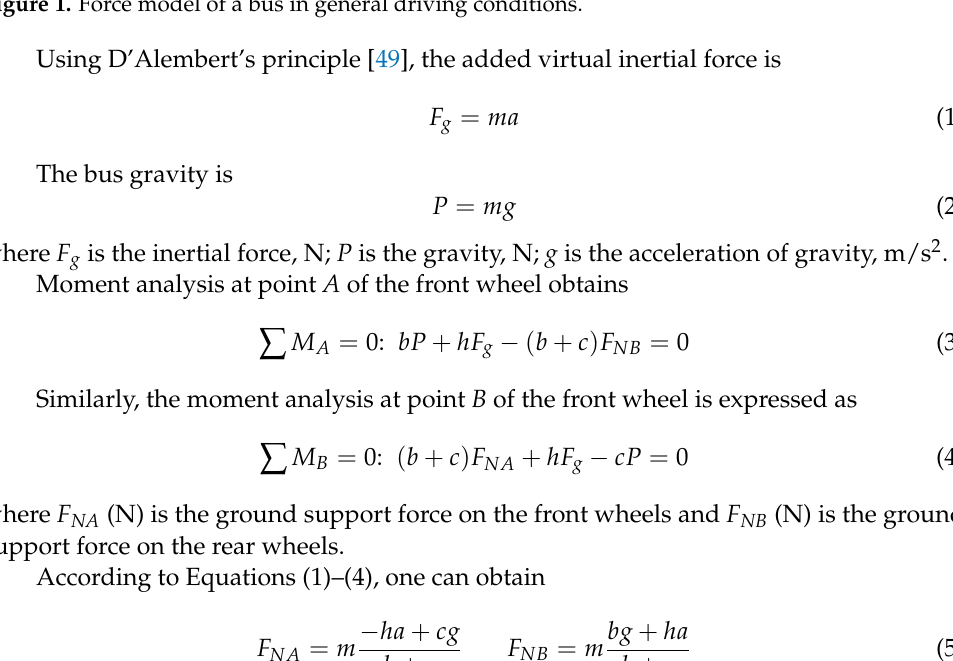
Figure 1. Force model of a bus in general driving conditions.